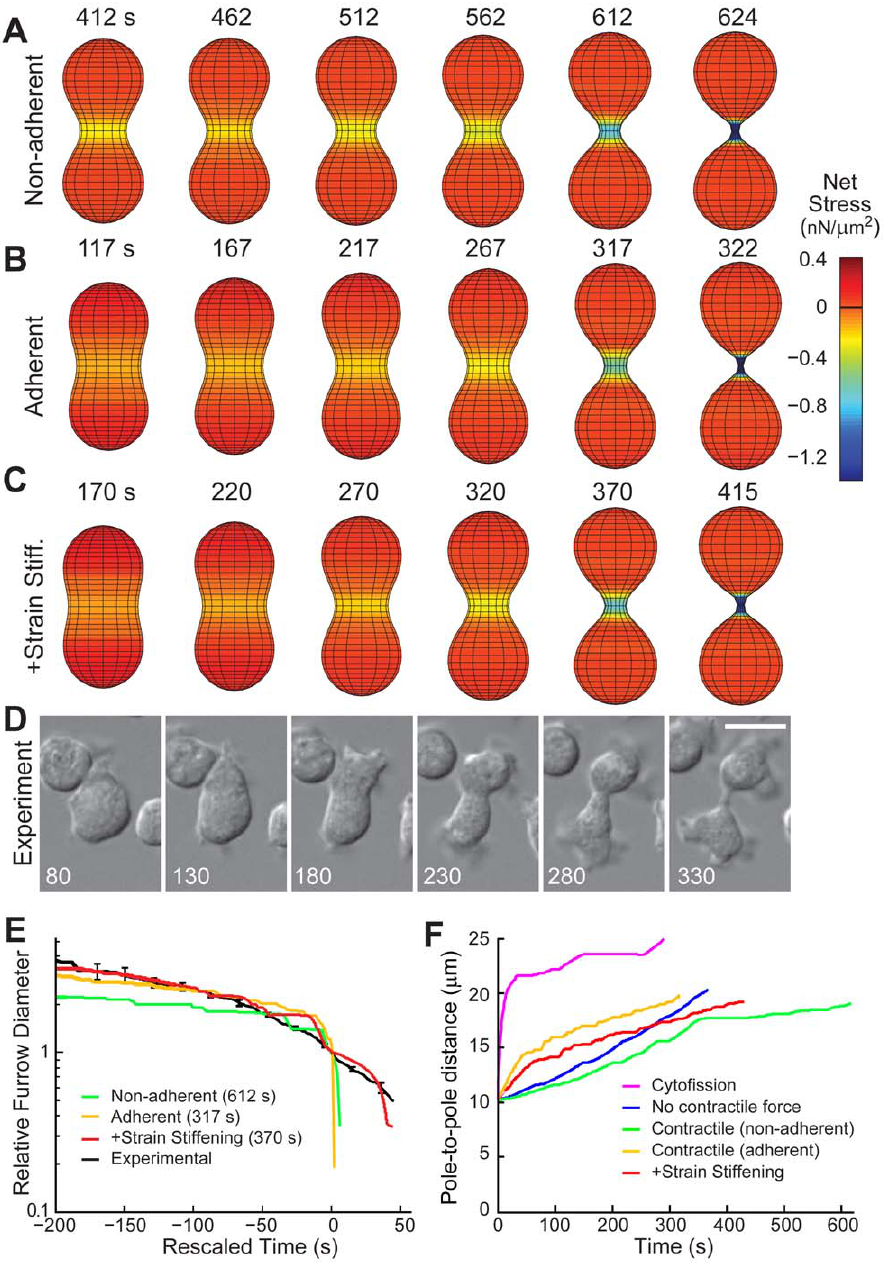
Figure 4. Cell division in the presence of a contractile force. Simulation of dividing cells in both non-adherent (A; Video S4) and adherent conditions (B; Video S5). In the latter we also considered the effect of strain-stiffening as defined by Equation 11 (C; Video S6). Simulation times are from theinitial spherical shape. D.Experimentalcomparison iswith WTcells. Experimental timesarefromVideo S7. Scale bardenotes10 m m. E. Comparison of furrow thinning trajectory. Experimental data represent the mean 6 SEM and are taken from reference [12]. We rescaled the time axis to compare the shapes at comparable times, by shifting the time so that the cross-over times are denoted as 0 s (Methods). The elapsed time between the start of the simulation and the cross-over time for each simulation is given in the legend. F. Pole-to-pole distance as a function of time.